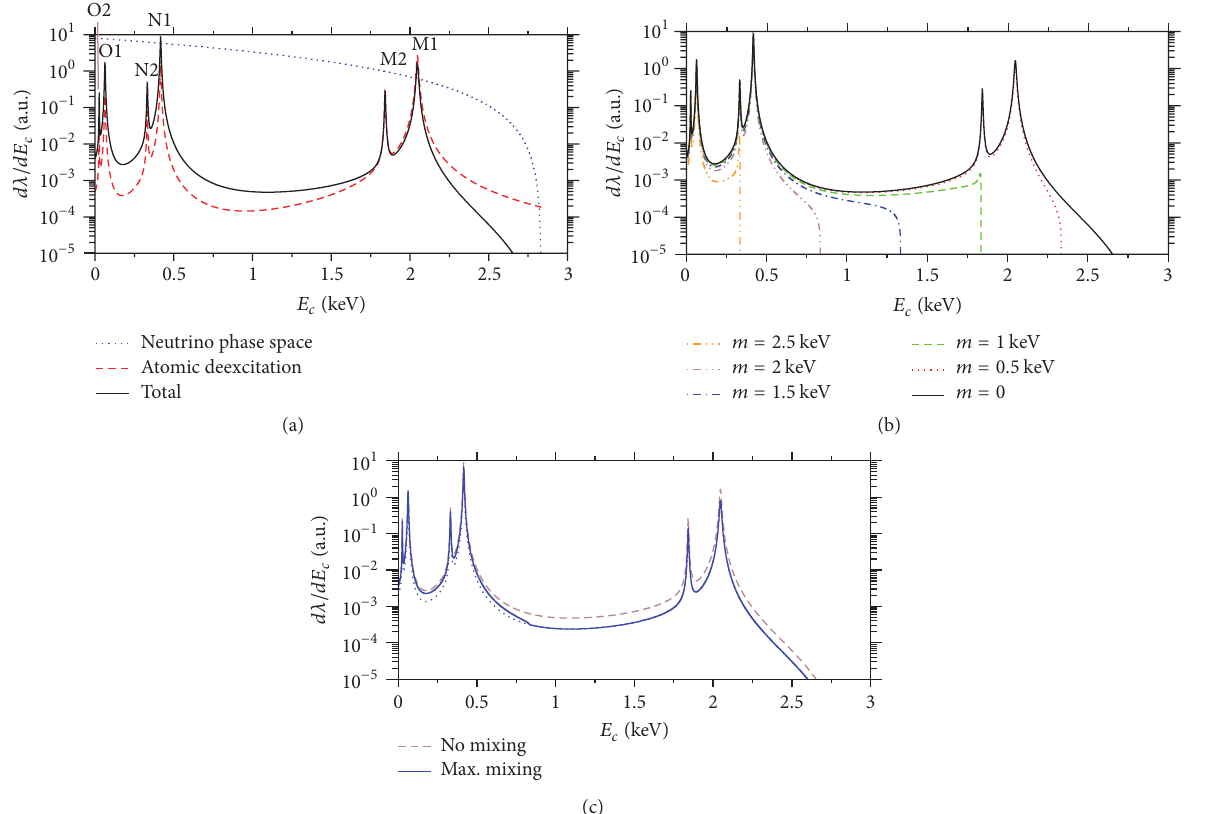
Figure 1: Calorimeter spectrum after electron capture in 163 Ho. (a) Full spectrum (solid curve) and contributions: emitted neutrino phase space (dotted curve) and daughter atom deexcitation (dashed curve). (b) Full spectrum for different neutrino masses: 0, 0.5, 1, 1.5, 2, and 2.5 keV. (c) full spectrum for light ( 𝑚 𝑙 ≈ 0 keV) - heavy ( 𝑚 ℎ = 2 keV) neutrino mixing using a maximal mixing angle 𝜁 = 45 ∘ for illustration, with (solid curve) and without (dotted curve) the heavy neutrino contribution. For comparison, the spectrum without heavy neutrino mixing (dashed curve) is also shown. We use the maximal unrealistic value 𝜁 = 45 ∘ to make the effect visible in the scale of the figure. Realistic values of 𝜁 < 0.01 ∘ result in a reduction of the difference between the dashed and the solid lines in (c) by more than seven orders of